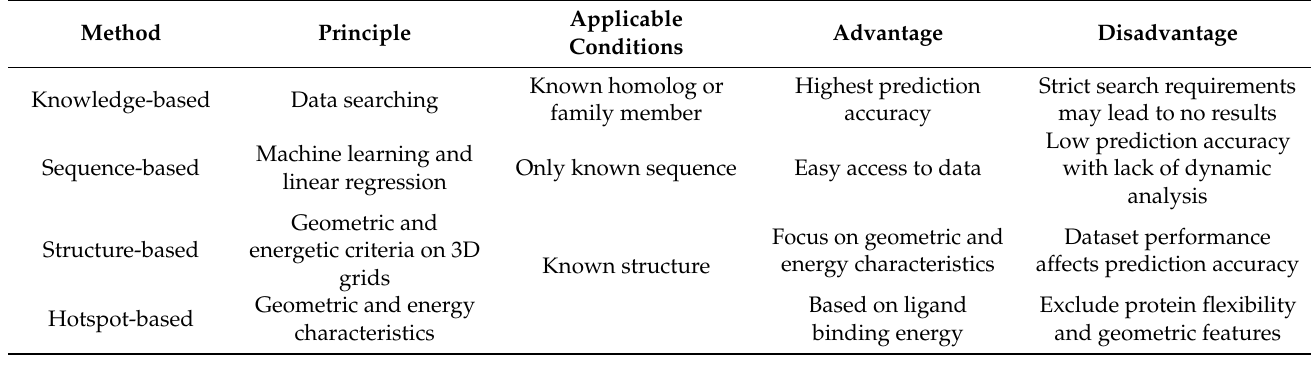
Table 2. Comparison of methods for the assessment of druggability.